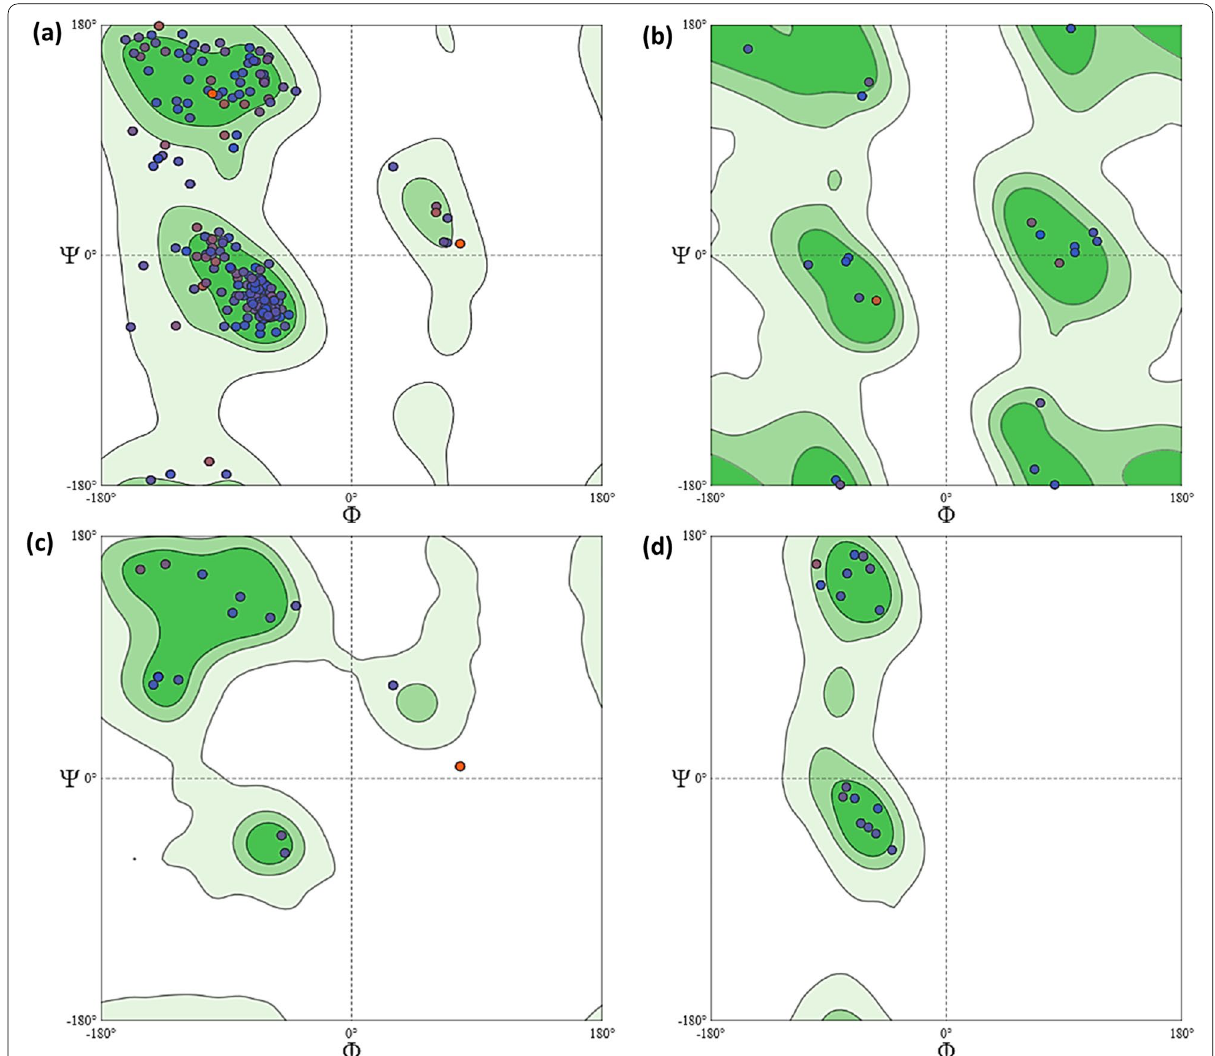
Fig. 4 Ramachandran’s plot calculations on the 3D models of peroxidase of Aspergillus niger AN512 computed by the SWISS‑MODEL web‑server to show the favored regions for backbone dihedral angles against of amino acid residues in protein structure a ) General (No Proline or Glycine) b ) Glycine Only c ) Pre‑Proline Only d ) Proline